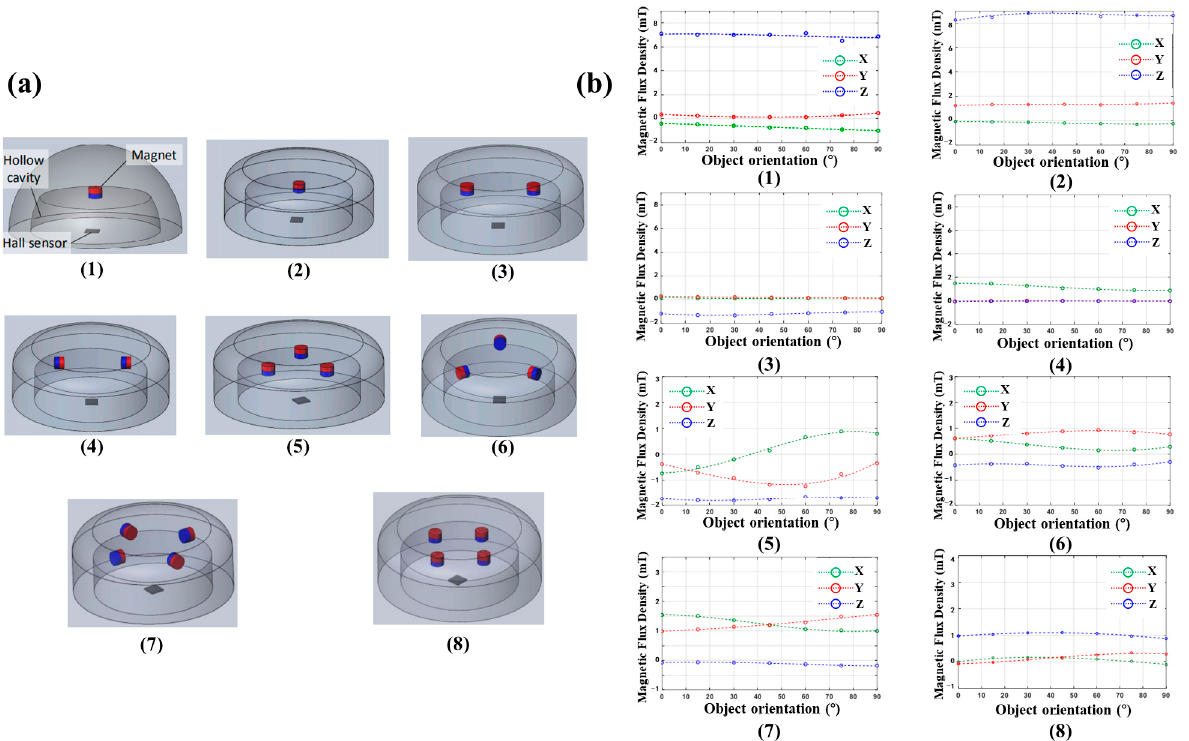
Figure 6. ( a ) Eight placement methods of permanent magnets. Reprinted with permission from Ref. [48]. Copyright 2019, MDPI; ( b ) Experimental data and fitting curves of 8 designs. The green, red and blue circles are the magnetic flux densities of the X, Y and Z axes measured by the sensor. The dotted green, red and blue lines are the fitting curves. Reprinted with permission from Ref. [48]. Copyright 2019,